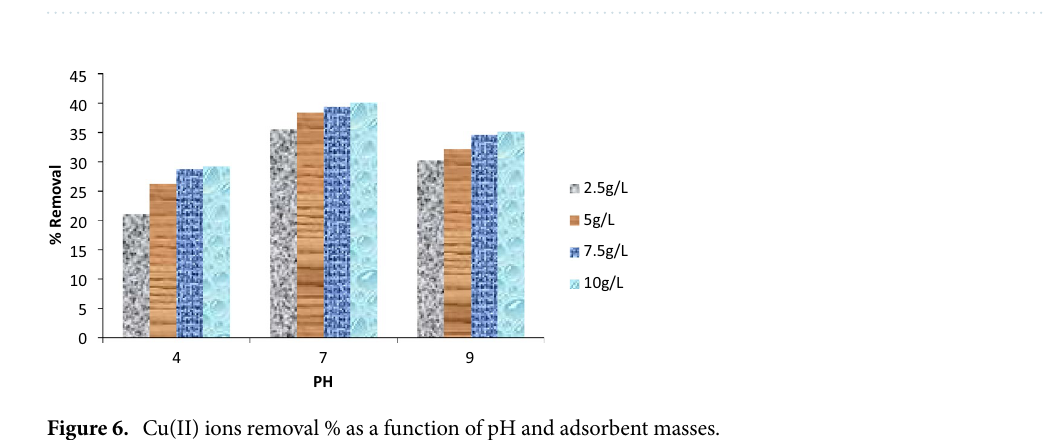
Figure 5. SEM images of Cs ( a ), Cs-g-PVP ( b ), Cs-g-PVP/f-MWCNT 3wt% ( c ), and Cs-g-PVP/f-MWCNT 5wt% ( d ).